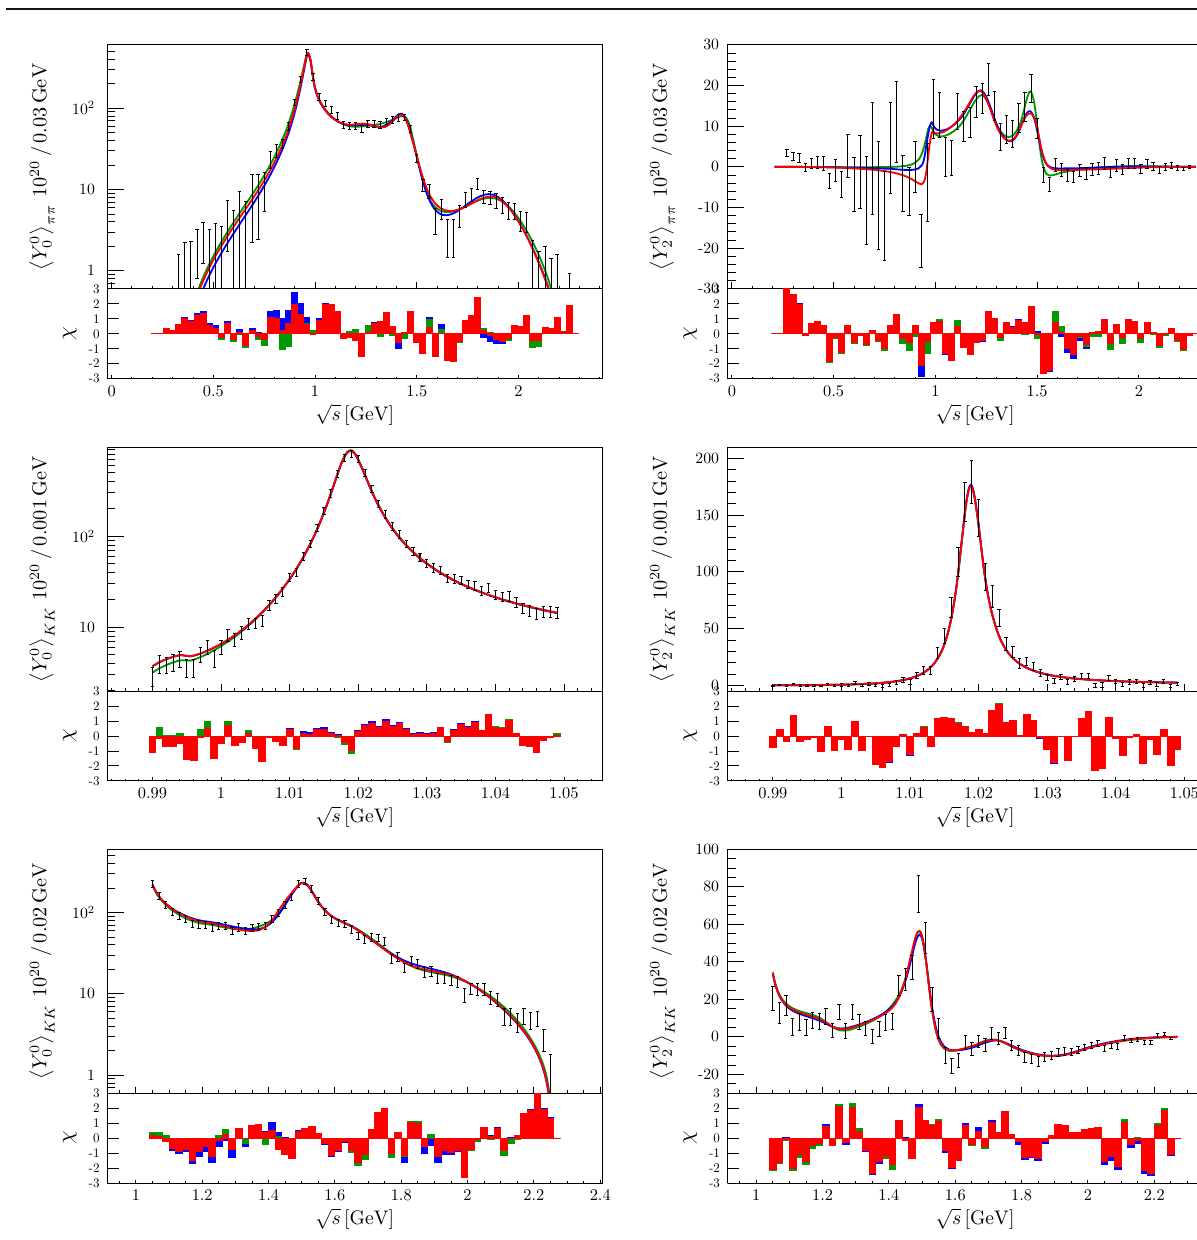
Fig. 5 Angular moments J /ψ π + π − (top two) and ¯ B 0 s → J /ψ K + K − (bottom four) with an effective σσ channel. The picture shows Fit 1 in blue, For narrow resonances located far from relevant